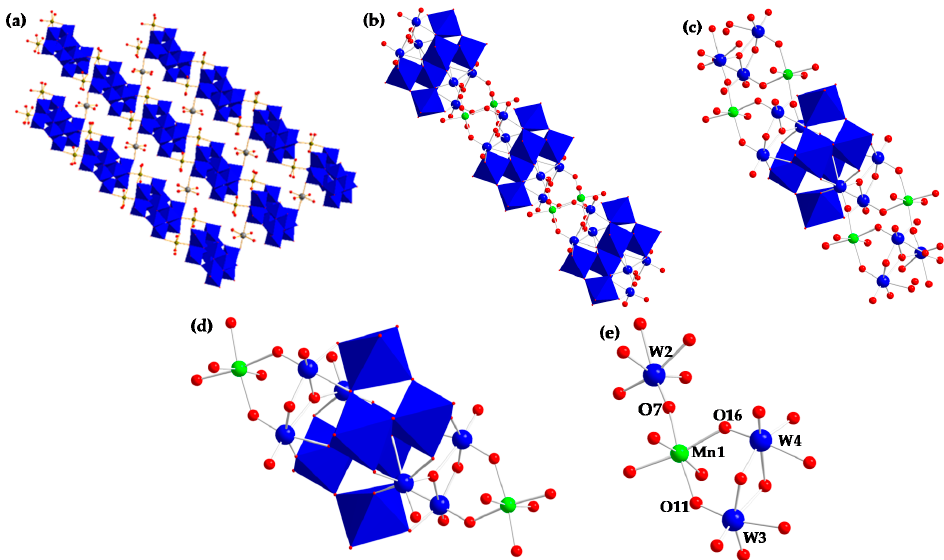
Figure 1. Polyhedral and ball-and-stick representations of 1 . ( a ) Extended 2-D network; ( b , c ) [(Mn(H 2 O) 3 ) 2 (H 2 W 12 O 42 )] n 6 n − chains; ( d ) [(Mn(H 2 O) 3 ) 2 (H 2 W 12 O 42 )] 6 − monomer; ( e ) Mn–O–W connections. Blue octahedral: WO 6 ; blue balls: “cap-type” W; red balls: O; green balls: Mn; grey balls: Figure 1.